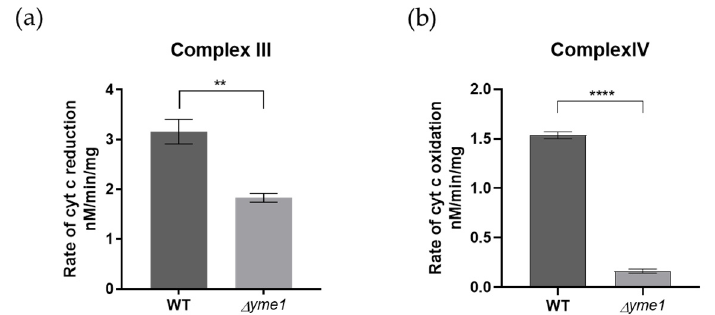
Figure 8. In-solution activity analysis of the mitochondrial complexes III and IV. Mitochondria were isolated from cells grown in YPGal at 30 °C. ( a ) The activity of complex III, and ( b ) complex IV was measured using spectroscopic method. The error bars represent SEM of three independent experiments with the same mitochondrial preparation (n = 3). The statistic was done using Student’s t test, ** p < 0.01; **** p < 0.0001.